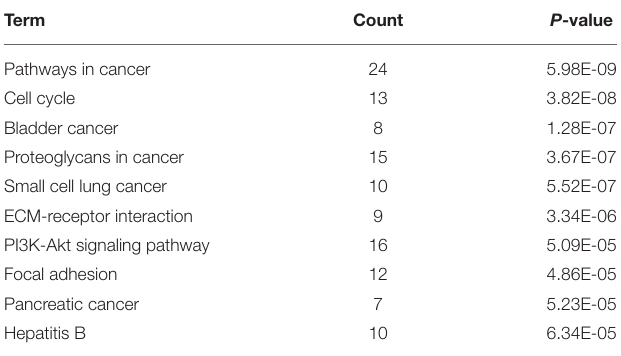
TABLE 2 | The top 10 enriched KEGG pathways for the intersection of target genes of downregulated DE-miRNAs and upregulated DE-mRNAs. Term